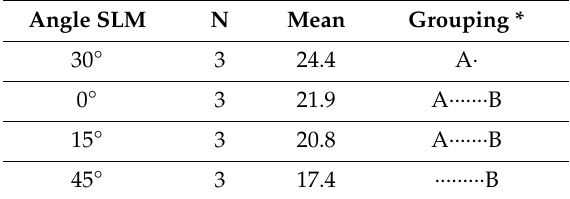
Figure 4. Roughness measurements ( Ra ) for the EBM and SLM samples: ( A ) comparison between average data within each group and ( B ) images of the surface mapping at di ff erent building angles; roughness measurement for the ( C ) EBM individual samples and ( D ) SLM individual samples. Table 5. Grouping information using the Tukey method and 95% confidence interval on the Ra measurements of the SLM